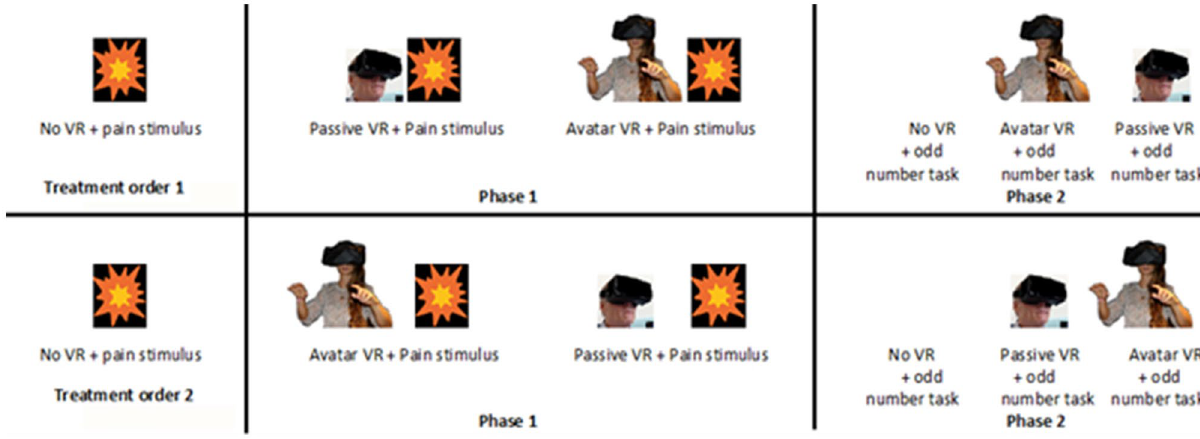
Figure 3. A detailed description of the stimulus sequence. Participants are randomly assigned to either Treatment Order 1 or Treatment Order